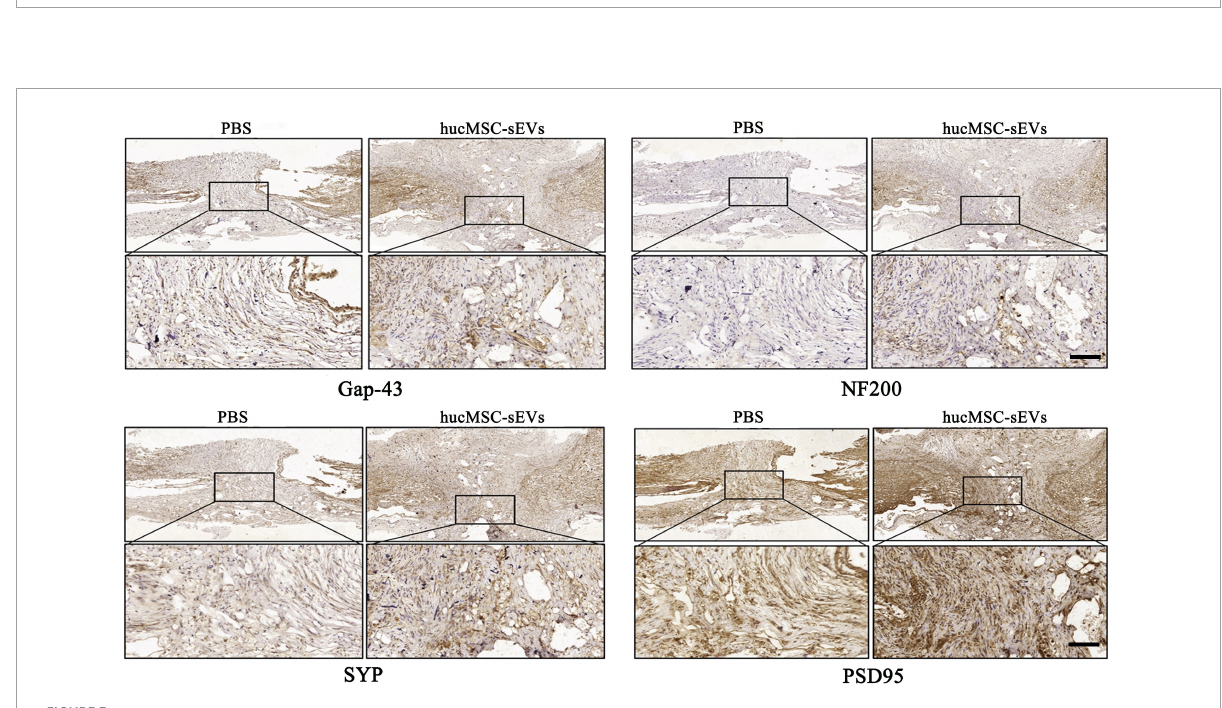
FIGURE3 hucMSC-sEVs promoted neurogenesis at the injury site. Immunohistochemical staining of different neural markers at the site of injury in the spinal cord 8 weeks after injury. Scale bars, 100 µ